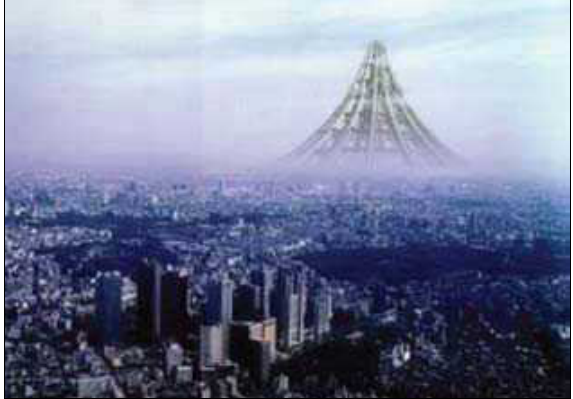
(archit. t. bernstrup, 2008 m.) Fig. 8. X-Seed 4000 building in tokyo port,